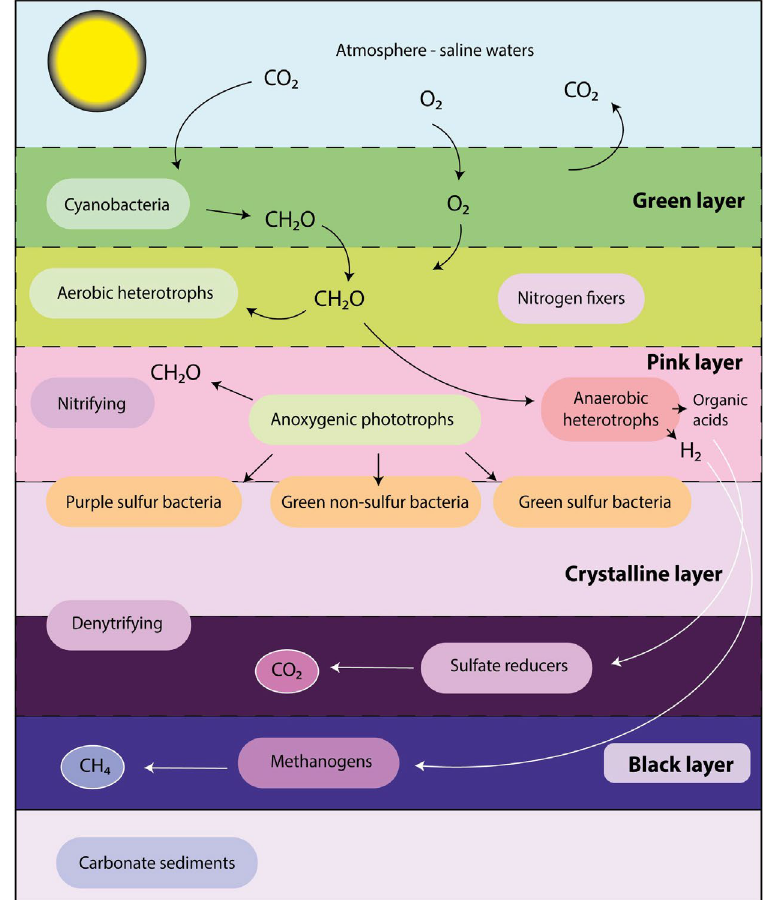
Figure 3. Schematic representation of the vertically stratified organization of microbial mats and the simplified carbon cycle that takes place on them. Adapted from Prieto-Barajas et al. (2018) [104].